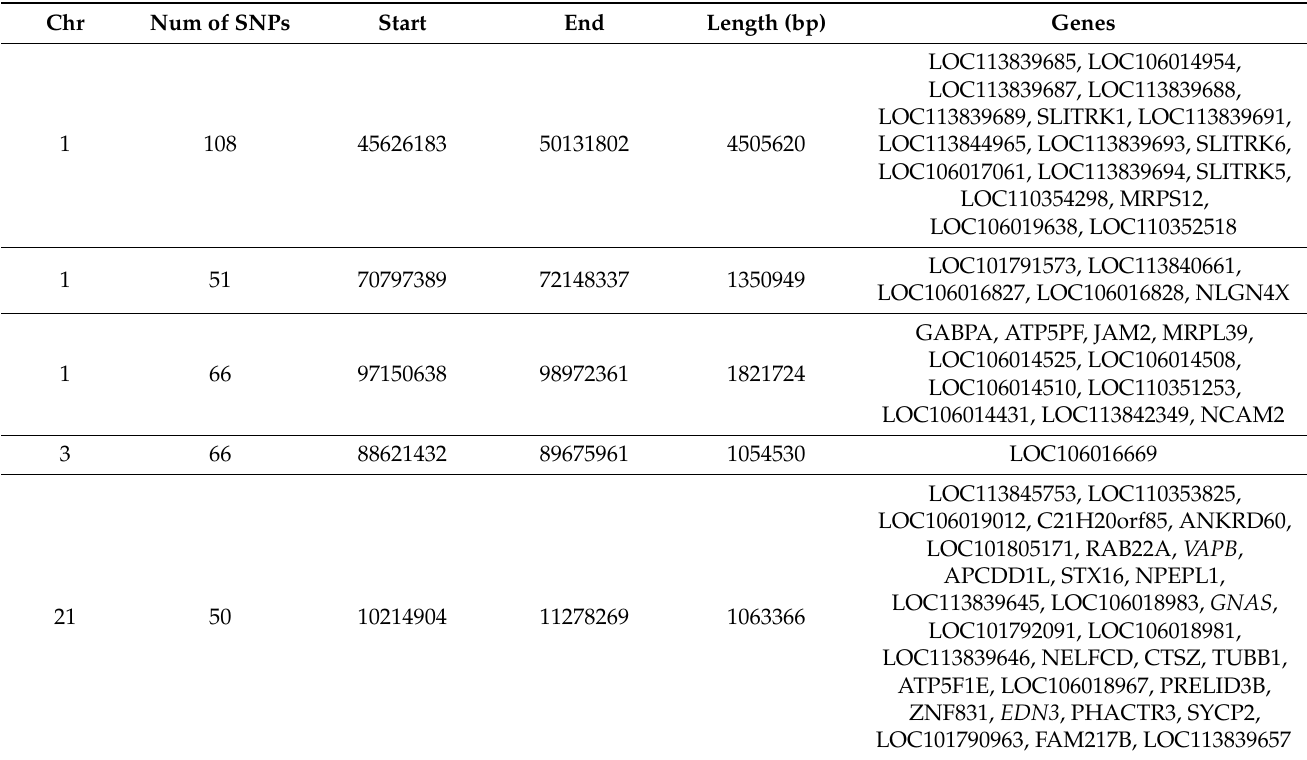
Table 1. Genomic regions of extended homozygosity (ROH islands) identified in the 4 indigenous duck